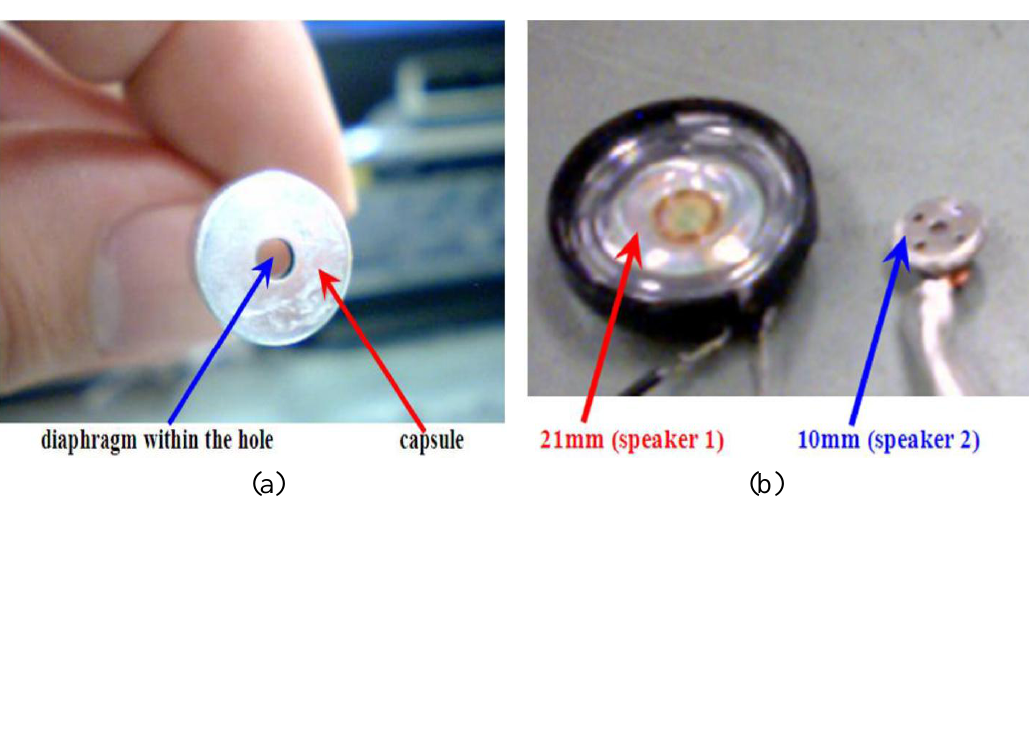
Figure 1. (a) Schematic diagram of an electret condenser microphone without the plastic package. (b) General view of two speakers; 21 mm in diameter (left) and 10 mm in diameter (right). (c) Schematic diagram of the overall arrangement. (d) Schematic diagram of the DVD plate, microphone and